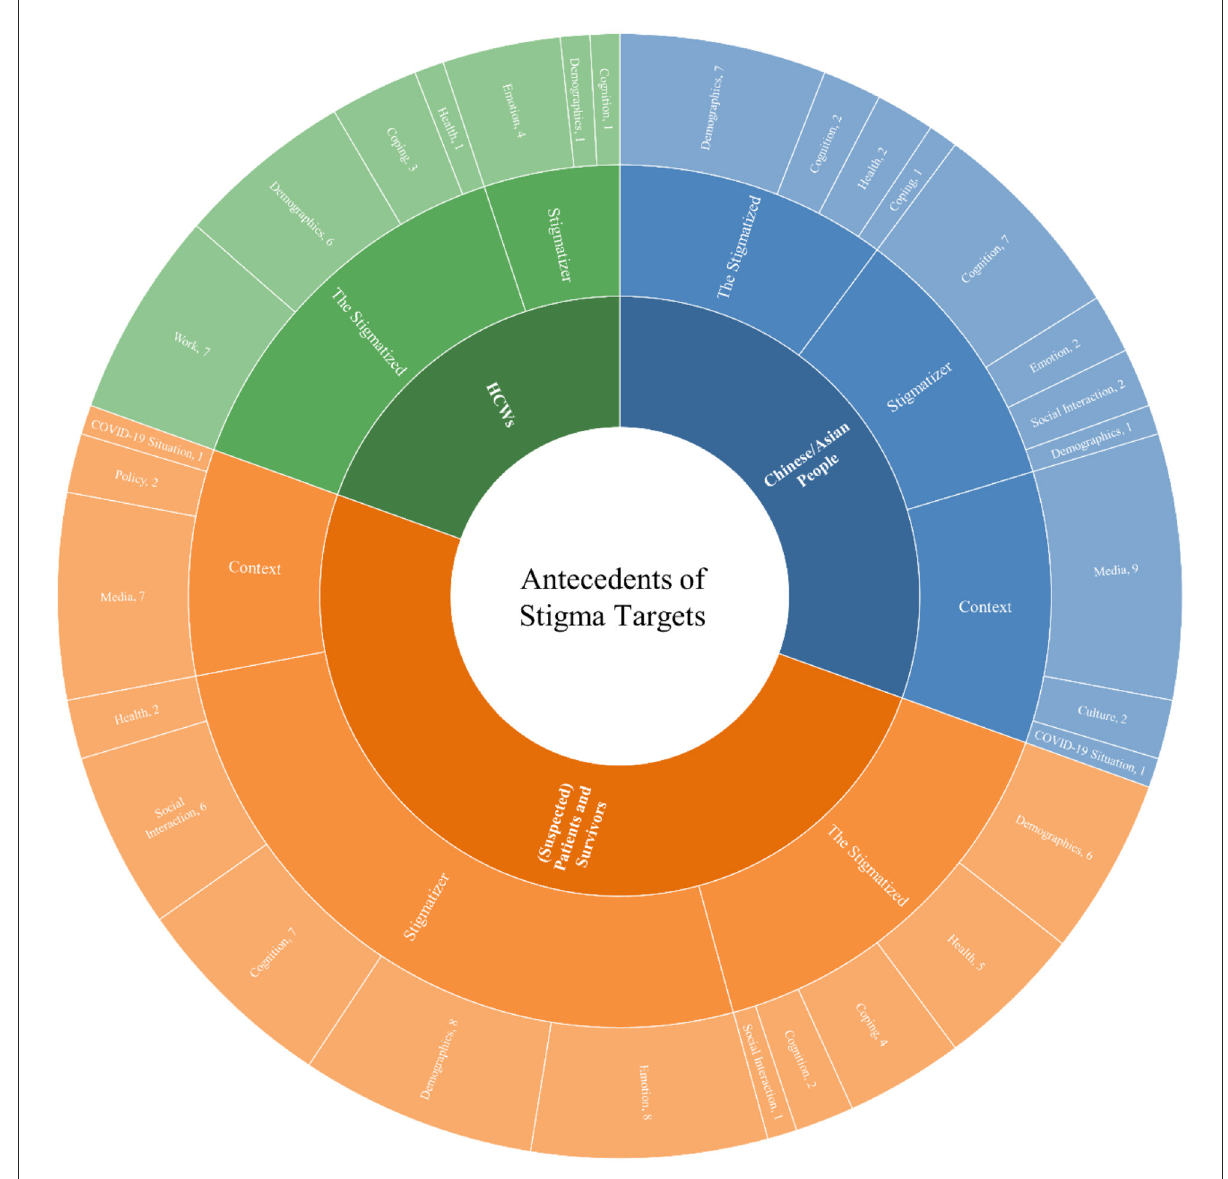
FIGURE3 Summary of the antecedents for stigma targets.